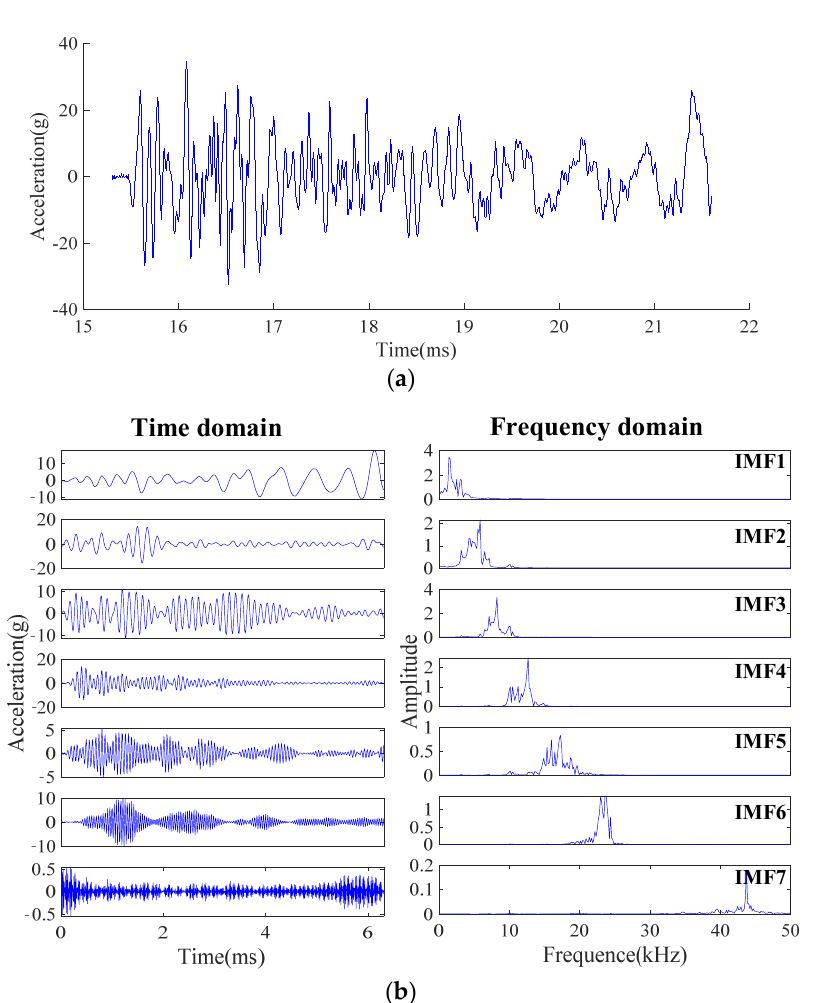
Figure 4. VMD results of the vibration signal. ( a ) Raw signal. ( b ) Time frequency domain results of IMFs.